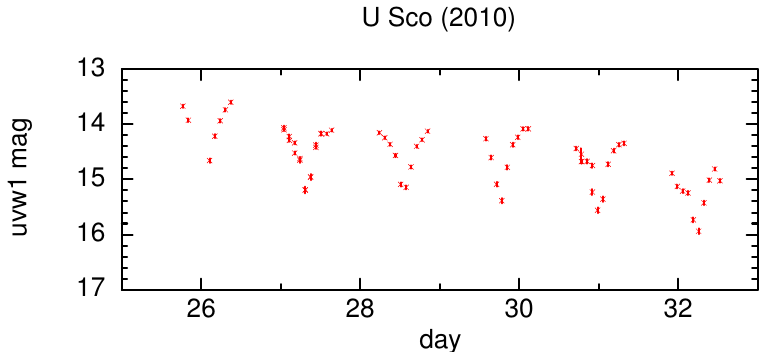
Figure 14. Zoom-in of part of the U Sco uvw 1 light-curve, showing a series of